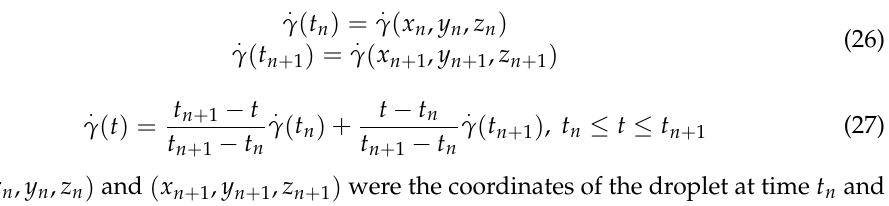
Figure 3. Set-up of a local model for droplet morphology evolution between t and t + ∆ t . . γ was not constant but calculated according to the location of the The shear rate droplet in the flow filed. For instance, given the locations of the droplet at time t n and t n + 1 by tracking the droplet trajectory, then the values of shear rate and viscosity at time t n and t n + 1 was obtained from the macroscopic simulation. During the timestep, the shear rate on . . γ γ the droplet was assumed linearly varying from to n n + 1